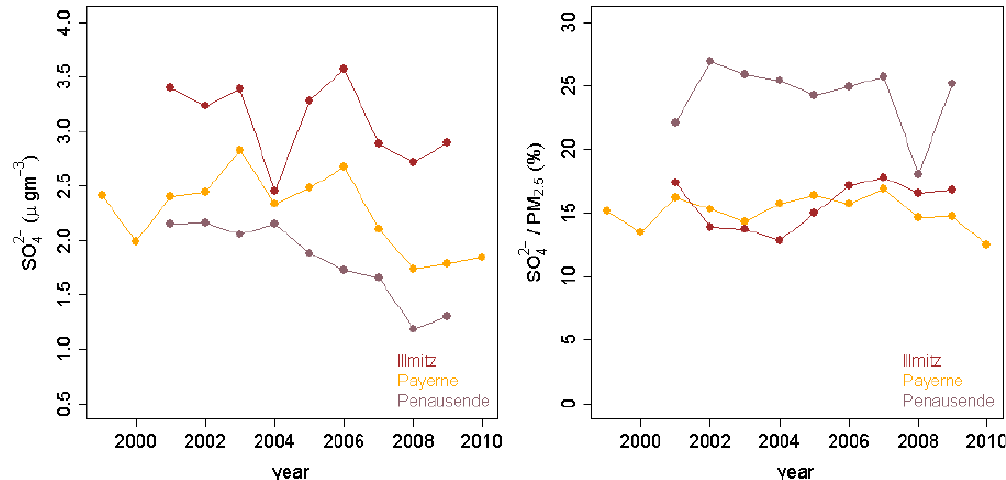
Fig. 9. Yearly average SO 2 −